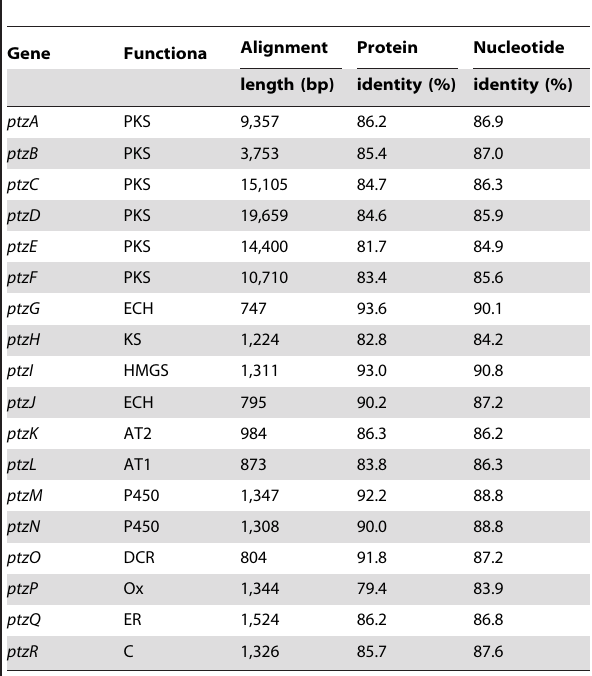
Table 5. Comparison of ptz genes in Ca. E. faulkneri L2 and L5.